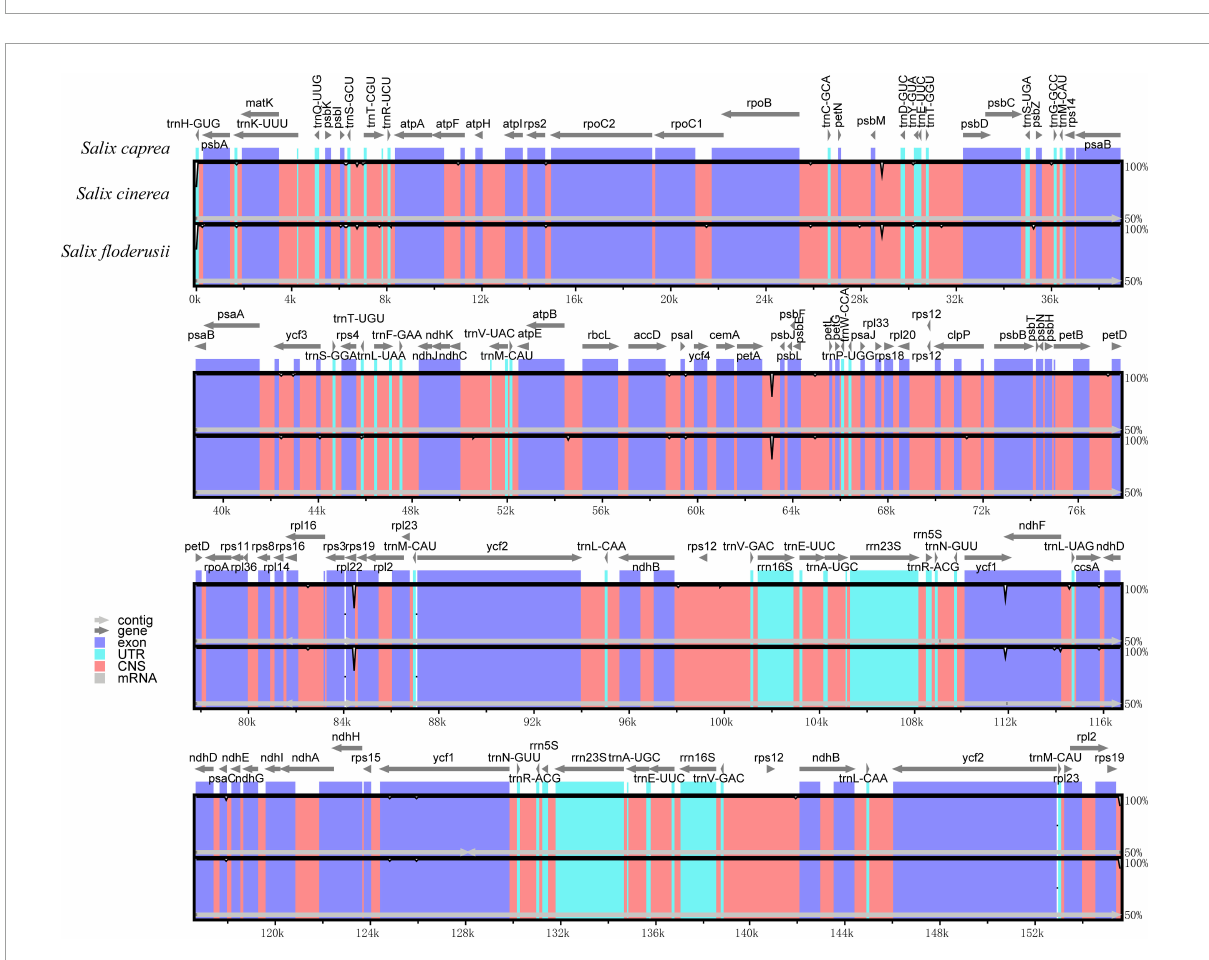
FIGURE7 Comparison of three cp genomes using the mVISTA alignment program. Genome regions are color-coded as protein-coding, rRNA coding, tRNA coding, or conserved non-coding sequences. The vertical scale shows the percentage of identity, varying from 50 to